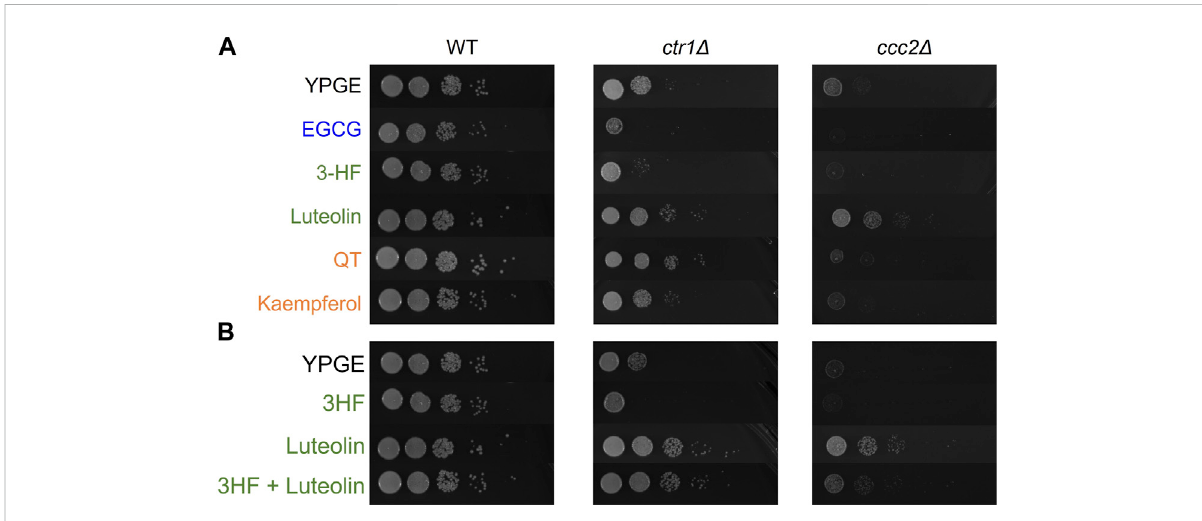
FIGURE 8 Seriallydiluted S.cerevisiae strainswerespottedonthenotedYPGEplatesandincubatedat37 ° Cfor4 daysbeforeimaging. (A) YPGEagarplates were prepared with 25 μ M of the noted fl avonoid. (B) Mixed ligand plates were prepared with 25 μ M of each noted fl avonoid. Treatment with mixed ligands exhibit changes suggestive of competition between ligands.